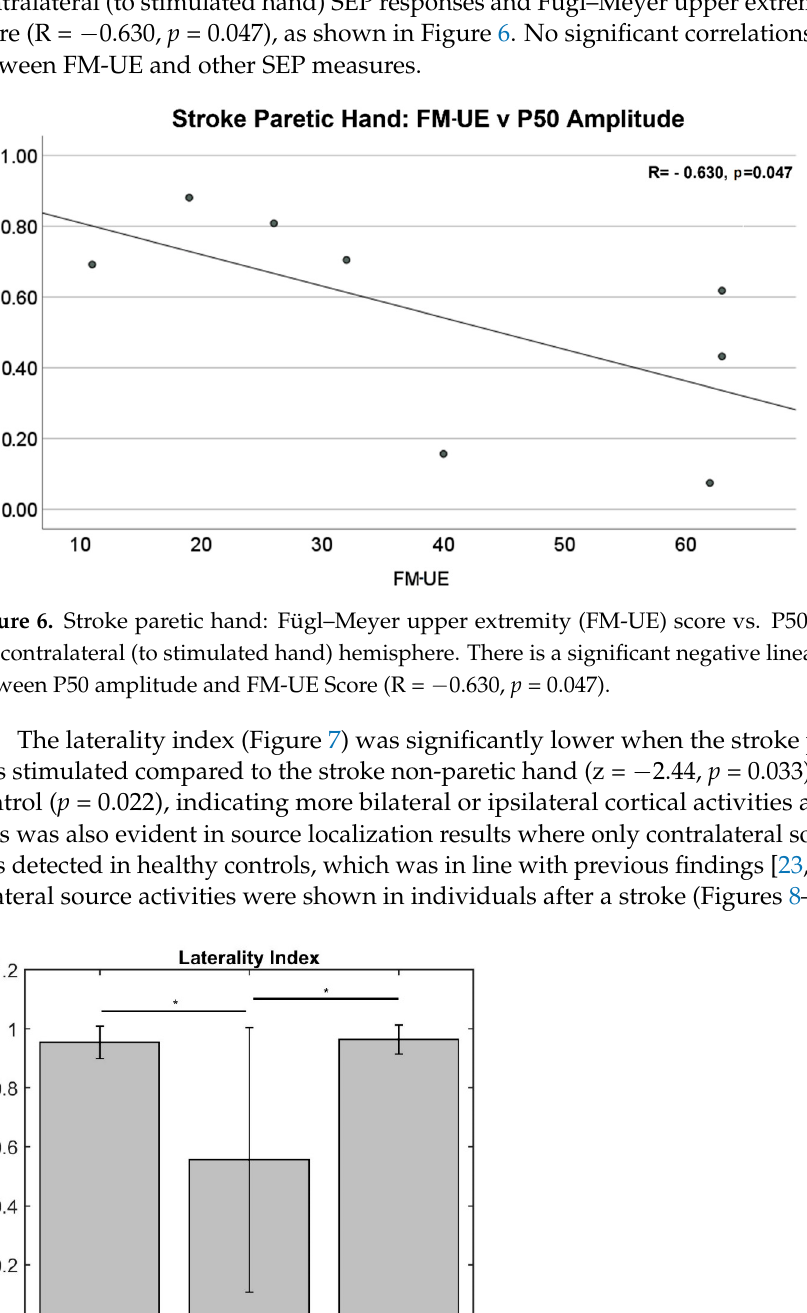
Figure 7. Laterality Index. Stars indicate statistically significant differences among control, stroke paretic hand (Stroke-P), and stroke non-paretic hand (Stroke-N): * < 0.05.